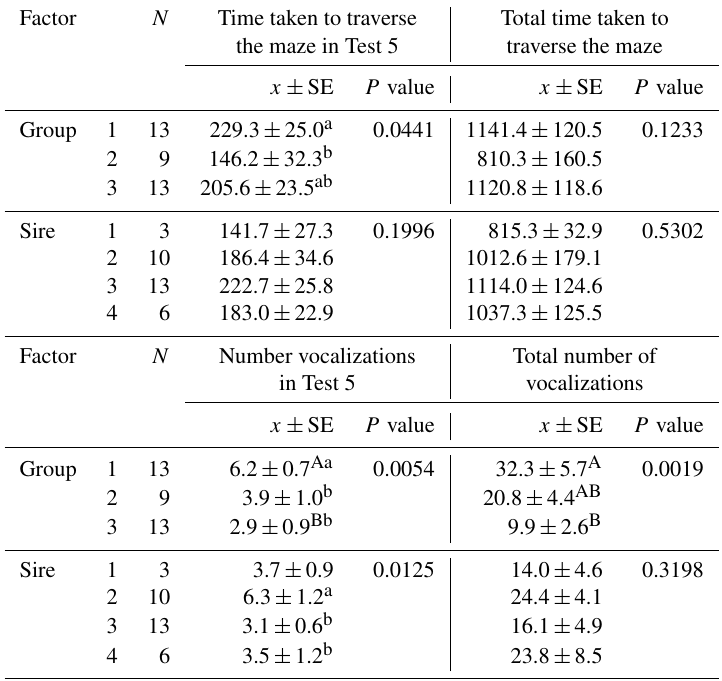
Table 2. Maze behaviour in the fifth month of the first